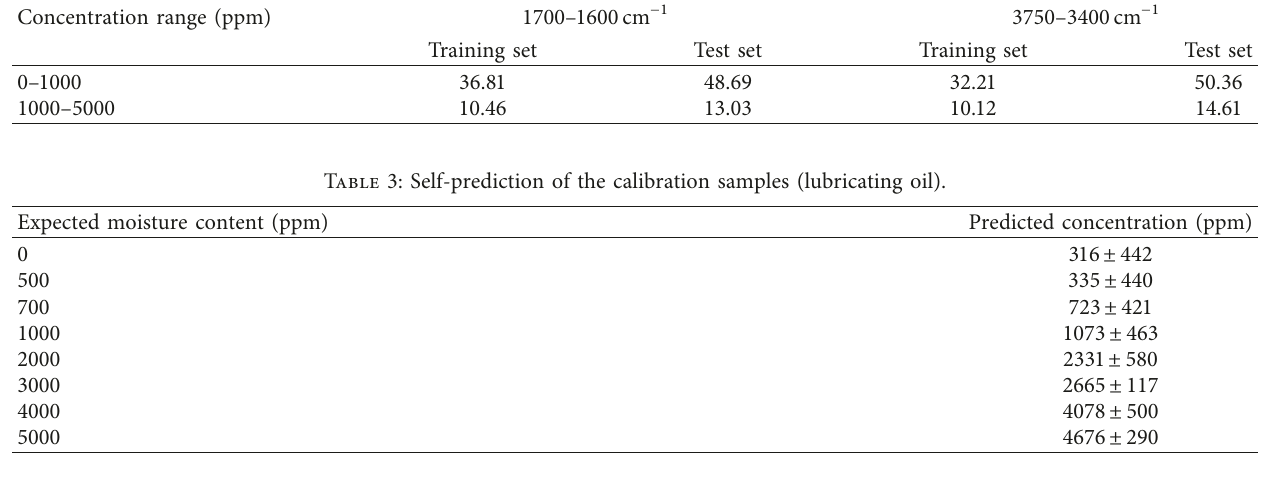
1 and the measurements attained using −